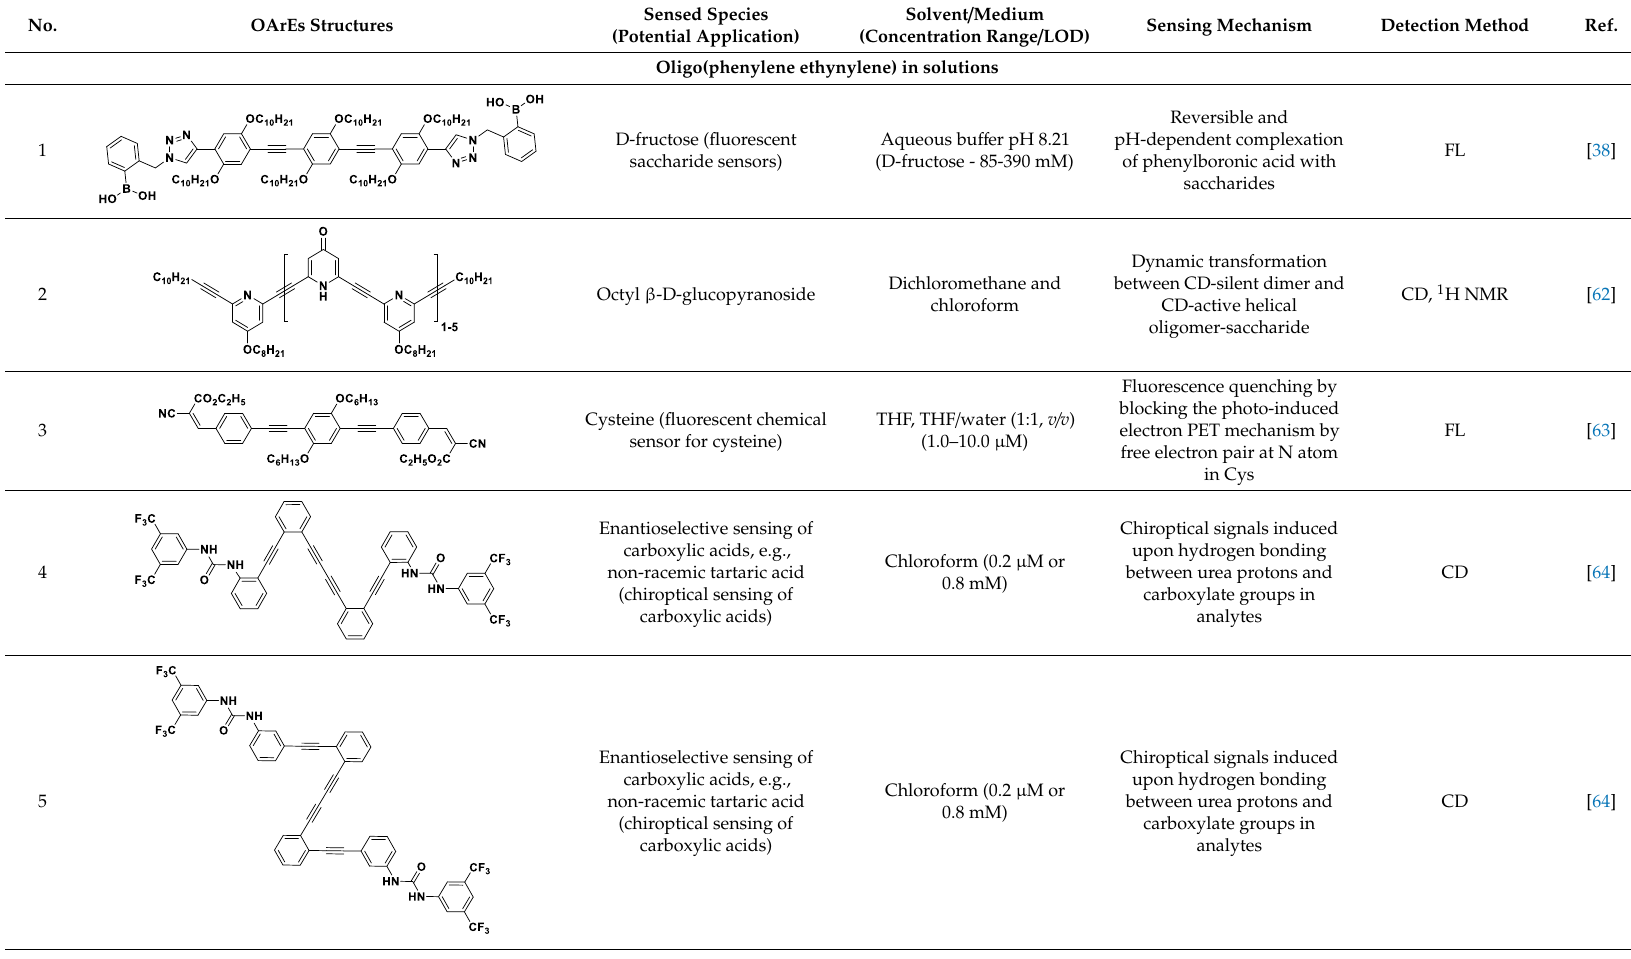
Table 1. Oligo(arylene ethynylene)s applied in sensing.